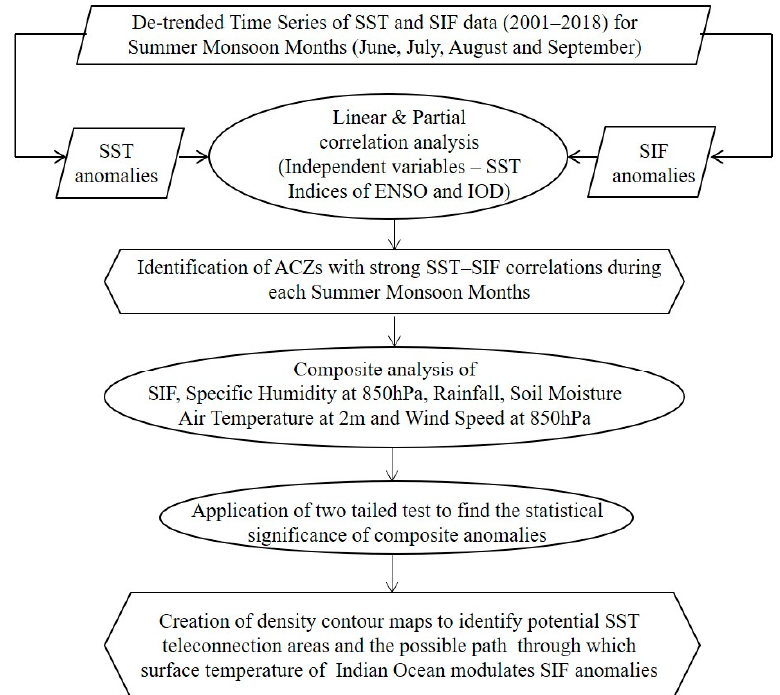
Figure 2. Methodology Flow Diagram with various steps followed for establishing the relationship between oceanic climate and terrestrial photosynthesis in the study